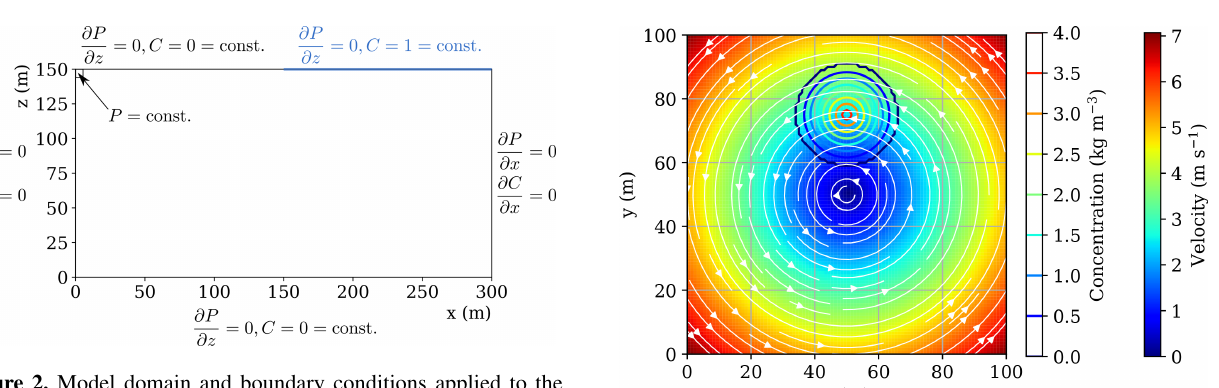
Figure 2. Model domain and boundary conditions applied to the Elder problem for numerical code validation. Table 2. Elder problem model parameters adapted from Kolditz et al. (1998).